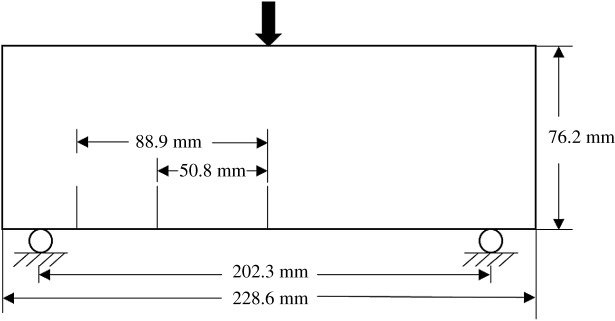
Model schematic.